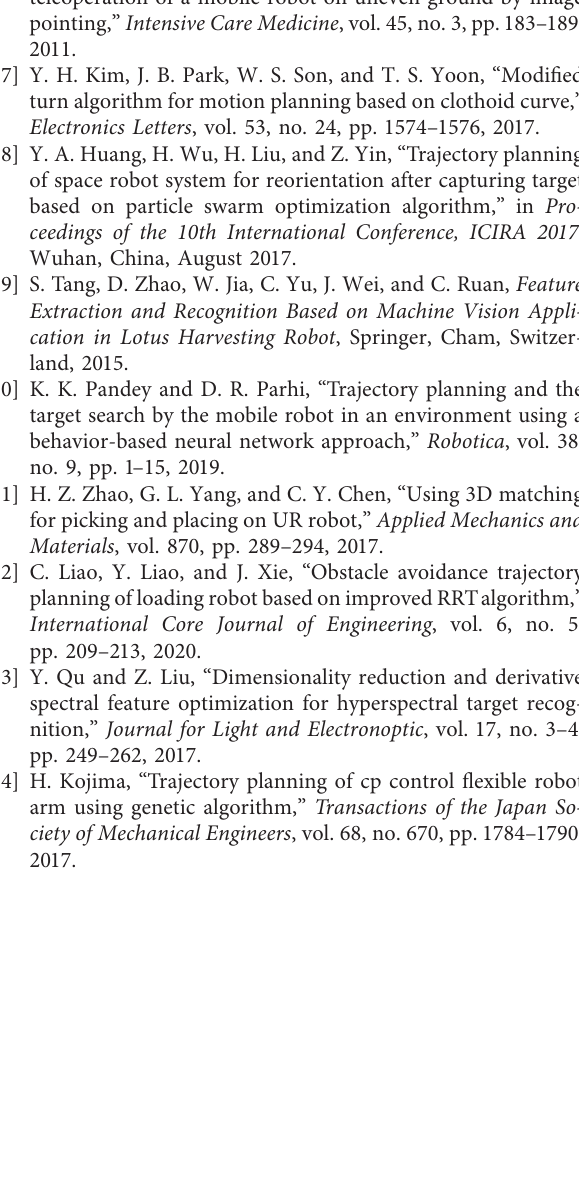
Algorithm 1 is about 1.15 seconds, and the specific